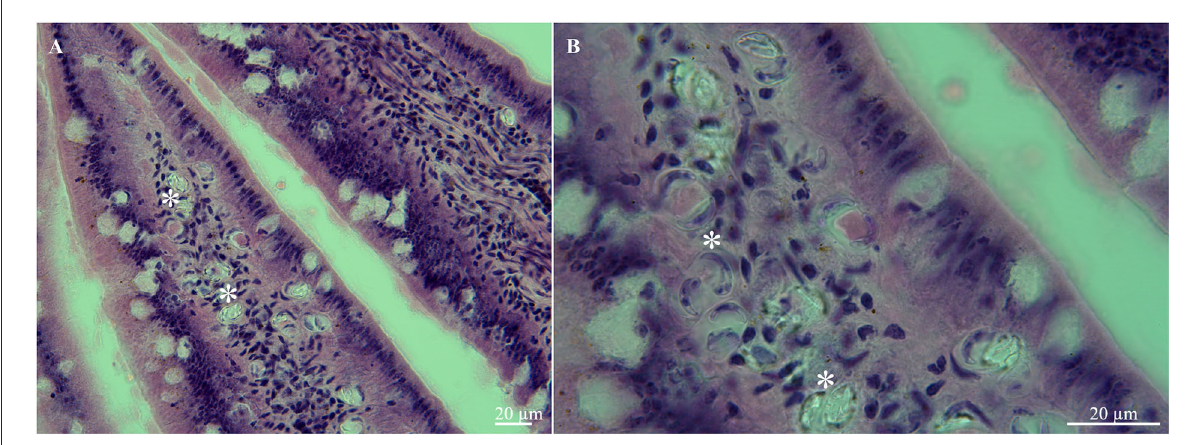
FIGURE2 Histological tissue sections of small intestine from the white-tailed eagle ( Haliaeetus albicilla ), (A) lamina propria of villi with multiple oocysts (asterisks), (B) same, higher